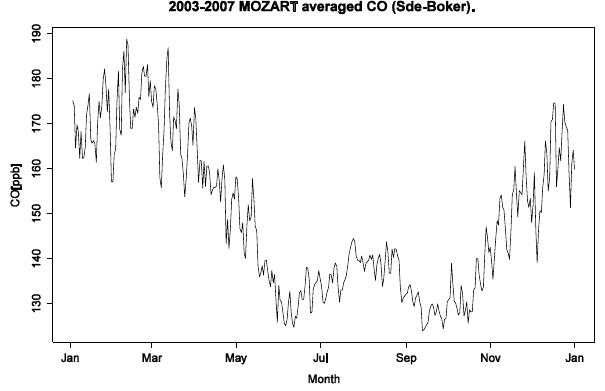
Fig. 6. Average CO surface concentrations (ppb) during the study Figure 6. Average CO surface concentrations (ppb) during the study period (2003-2007). period (2003–2007). A deviation from the expected seasonal cycle A deviation from the expected seasonal cycle during summer can be seen. during summer can be